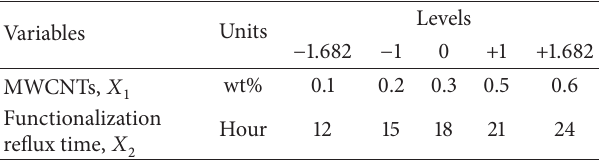
Table 1: Experimental codes and levels of independent variables for RSM optimization.